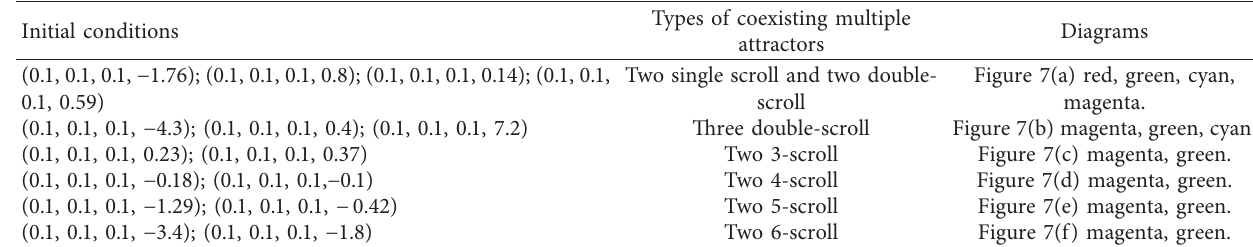
Figure 6: Bifurcation diagram and the Lyapunov exponent spectrum with respect to the initial conditions u (0) in region of [ − 4.8, 10]. Table 3: Extreme multistability behaviors of system